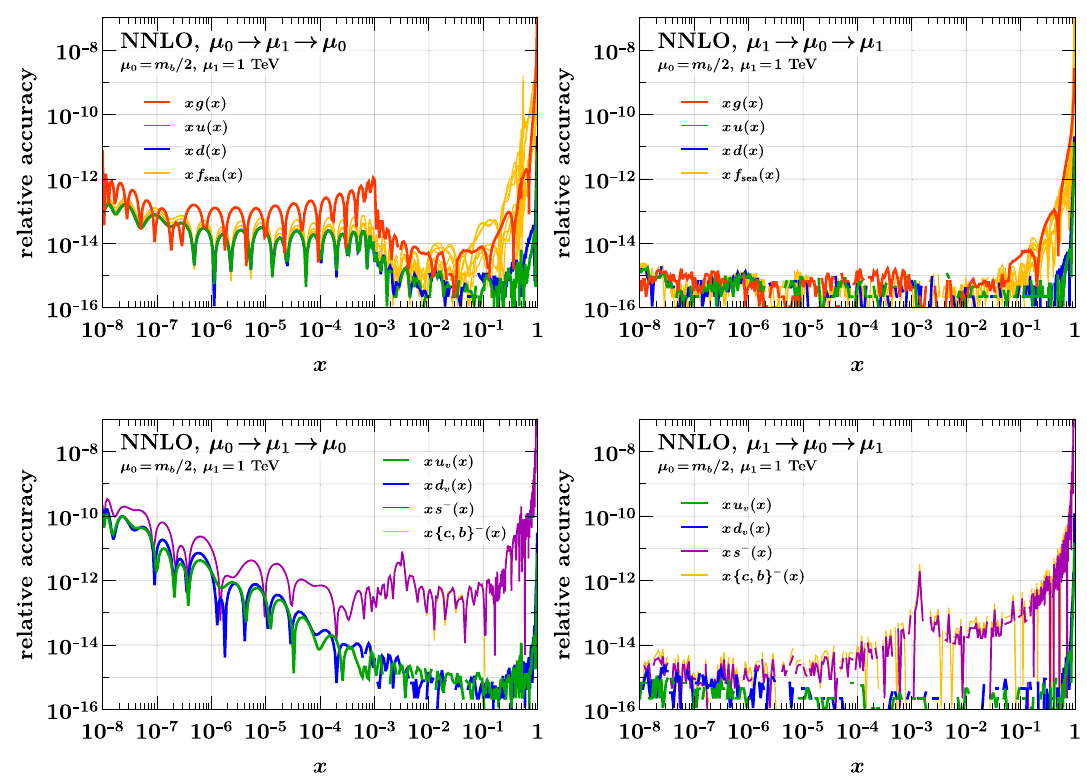
Fig. 14 RelativeaccuracyofNNLODGLAPevolutionatfixed n F = 5 from μ 0 → μ 1 → μ 0 (left) and from μ 1 → μ 0 → μ 1 (right). The scales are μ 0 = 2 . 25GeV and μ 1 = 1TeV, and the DOPRI8 method